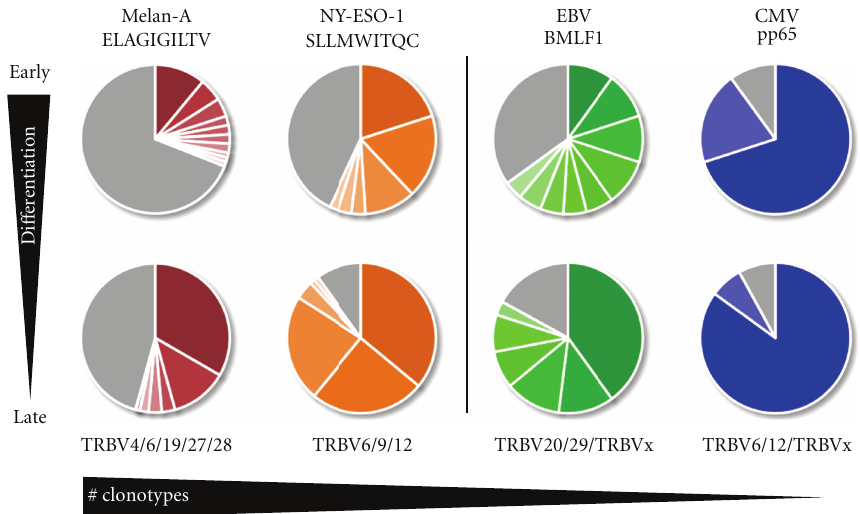
Figure 3: TCR repertoire restriction and TCR clonotype selection are driven by di ff erentiation. Analysis of TCR repertoire diversity and clonotype composition between tumor-specific responses (left side of the figure) and viral-specific responses (right side of the figure) suggest that all antigen-specific T-cell responses undergo selection along with progressive cellular di ff erentiation (top to bottom of figure). As such, early di ff erentiated subsets show a higher degree of clonal diversity relative to their more di ff erentiated subsets. Nevertheless, dominant clonotypes are also found in the former but make up significantly larger proportions of the more di ff erentiated compartments (defined as TCR clonotype selection) supporting a linear model of di ff erentiation. In addition, viral-specific responses which are composed of highly di ff erentiated cells (EMRA T-cells) also show a higher degree of TCR repertoire restriction compared with tumor-specific responses, evident not only in the late but also already in the early di ff erentiated subsets (indicated by a decrease in numbers of BV families and numbers of clonotypes from left to right). Each colored slice of pie represents a unique TCR clonotype, while the grey slices represent nondominant TCRs, that is, the sequences identified only once within the antigen-specific TCR repertoire. Melan-A (ELAGIGILTV) and NY-ESO-1 (SLLMWITQC) peptide sequences are indicated for the tumor-specific responses; virus specific T-cells were analyzed for the epitope EBV BMLF1 280–288 (GLCTLVAML) and for the CMV epitope pp65 495–503 (NLVPMVATV). All responses are HLA-A2 restricted. Preferential TRBV family usage is depicted based on IMGT’s nomenclature